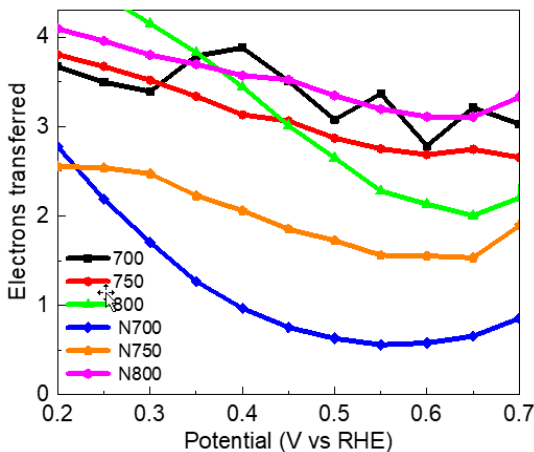
Figure 8. Electron-transfer numbers obtained from K-L plots for each synthesized electrocatalyst.